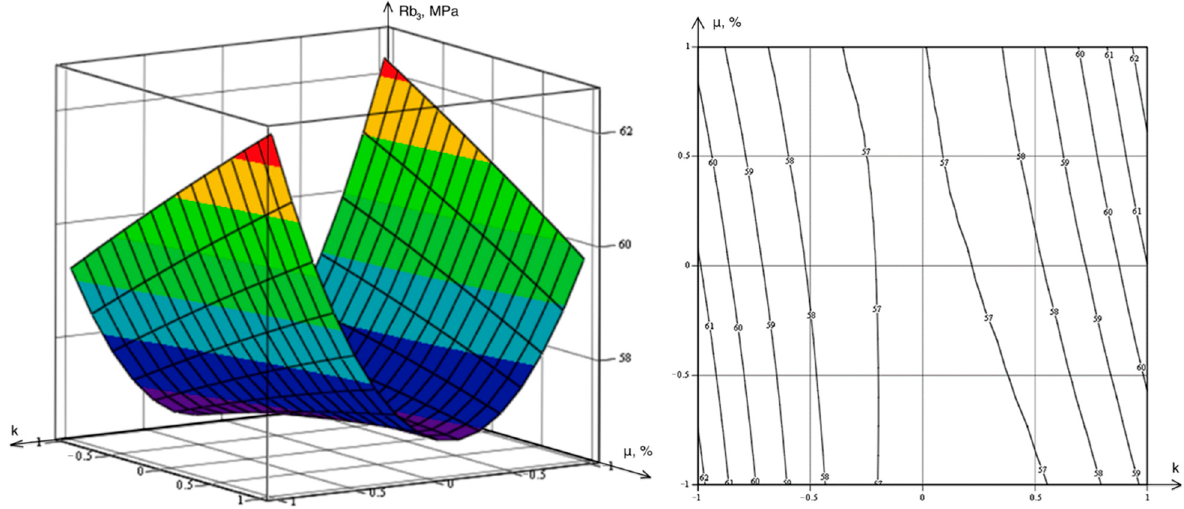
Figure 14. Dependence of the compressive strength of concrete reinforced with a combination of basalt and polypropy- lene